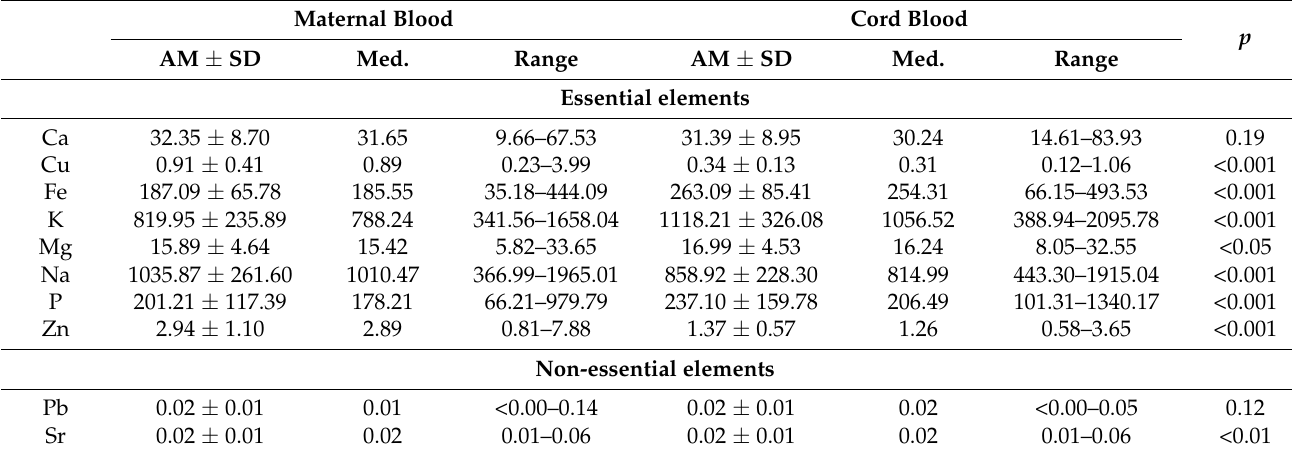
Table 3. The concentration of Ca, Cu, Fe, K, Mg, Na, P, Pb, Sr, and Zn in the maternal and cord blood. The concentration is expressed in mg/L (AM, arithmetic mean; SD, standard deviation; Med., median). Maternal